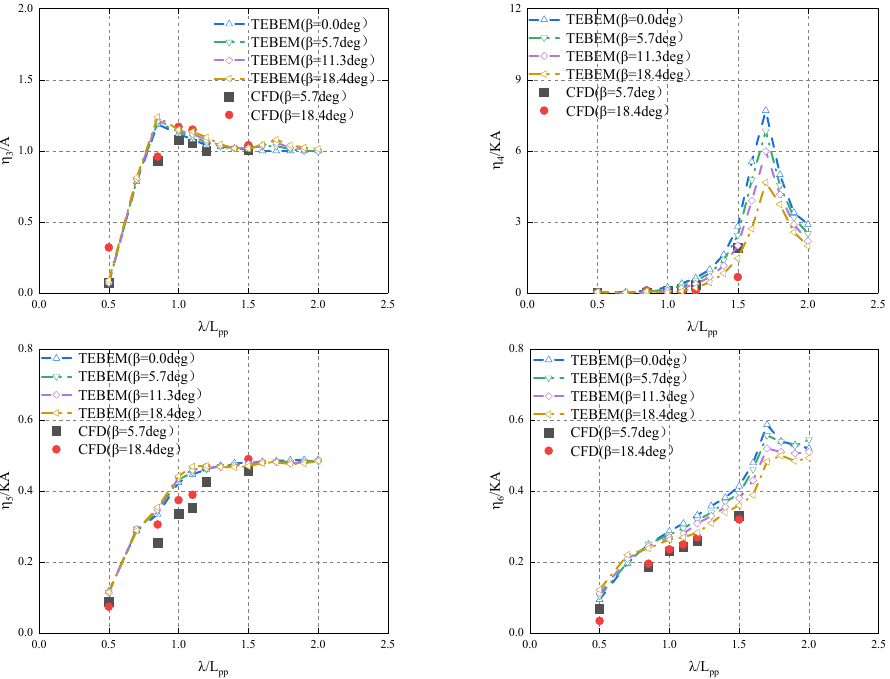
Figure 16. RAO of 6-DOF motion of KVLCC2 with H = 0.02 L PP , χ = 120°, β = 0°, 5.7°, 11.3°, 18.4°, and U = 6.0 kn.